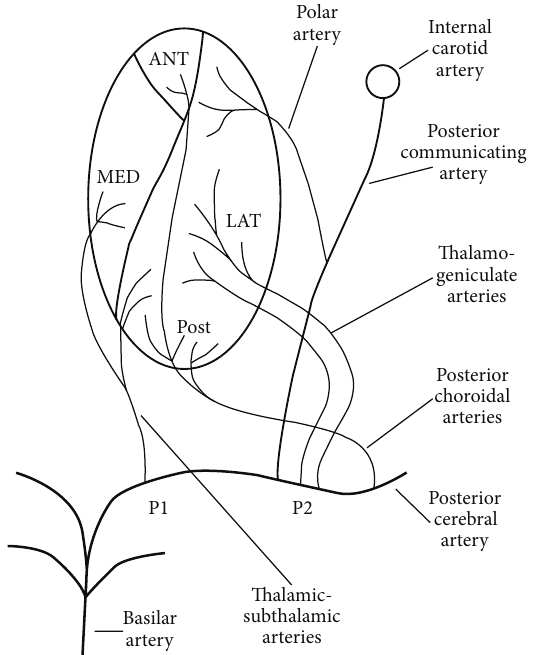
Figure 1: Schematic representation of the blood supply to the